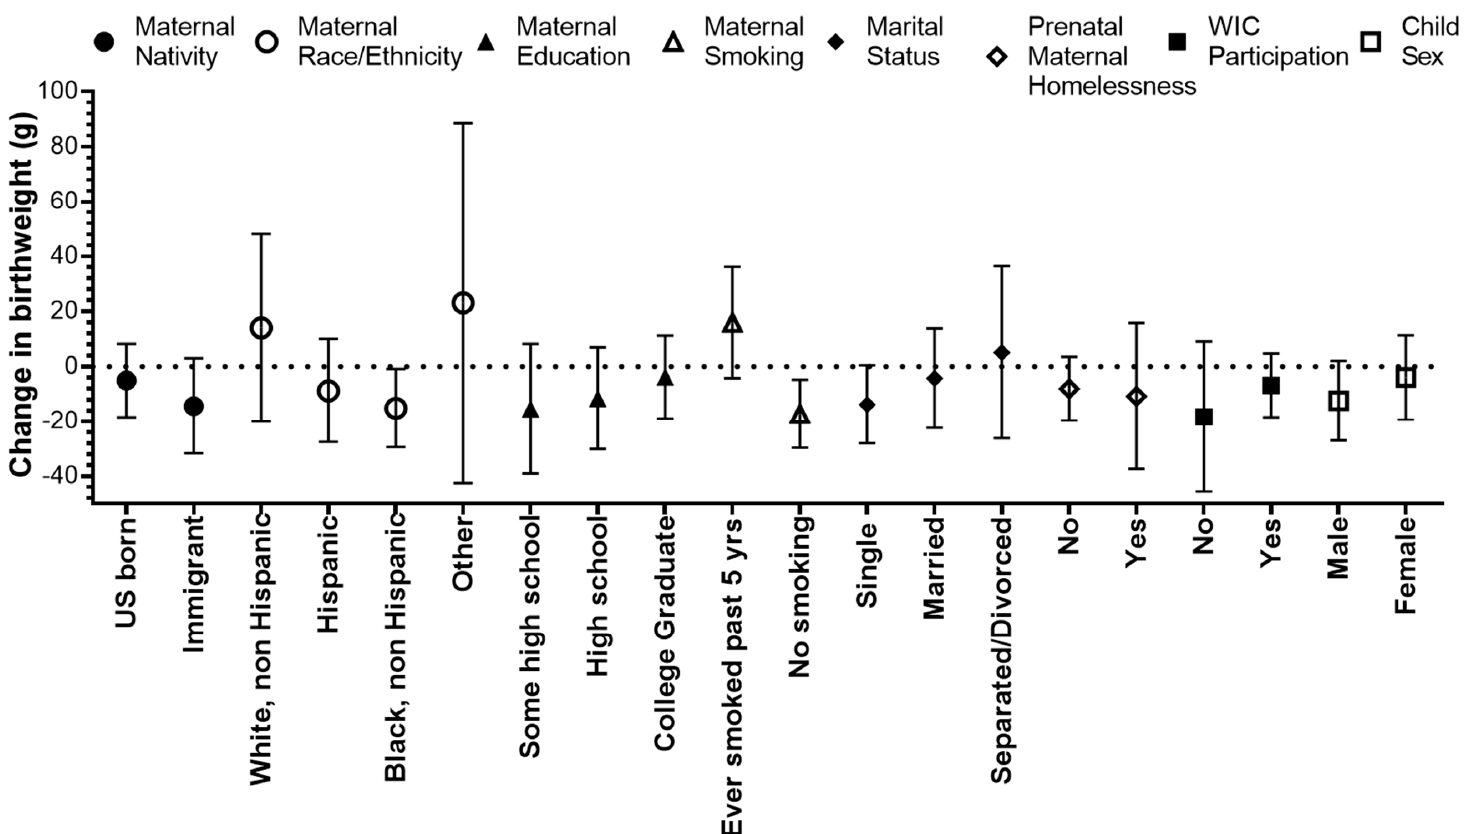
Figure 3. Change in birthweight (g) for a 1 µ g / m 3 increase in the average PM 2.5 during the 2nd trimester, stratified by maternal and child characteristics in the Boston-based Children’s HealthWatch